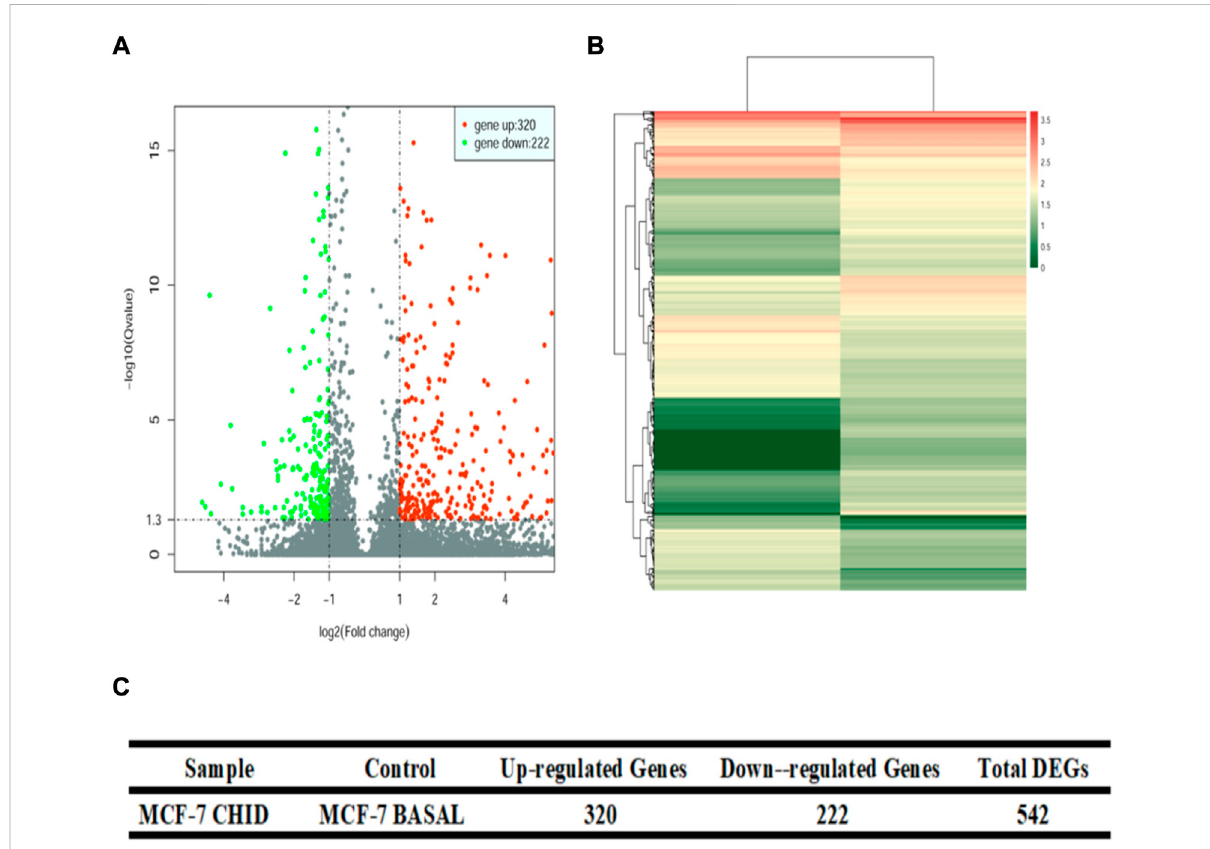
Volcano plot and Heat Map of differential expression gene. (A) : Volcano plot for differential gene expression analysis between samples. The horizontal coordinates represent the fold change of gene expression in different samples; the vertical coordinates represent the statistical signi fi cance of the difference in gene expression, red dots indicate signi fi cantly upregulated genes and green indicates signi fi cantly downregulated genes. (B) : Heat map of differential gene expression analysis between samples. Colors represent log 10 (expression value + 1) values. (C) : Quantitative analysis of differential gene expression between